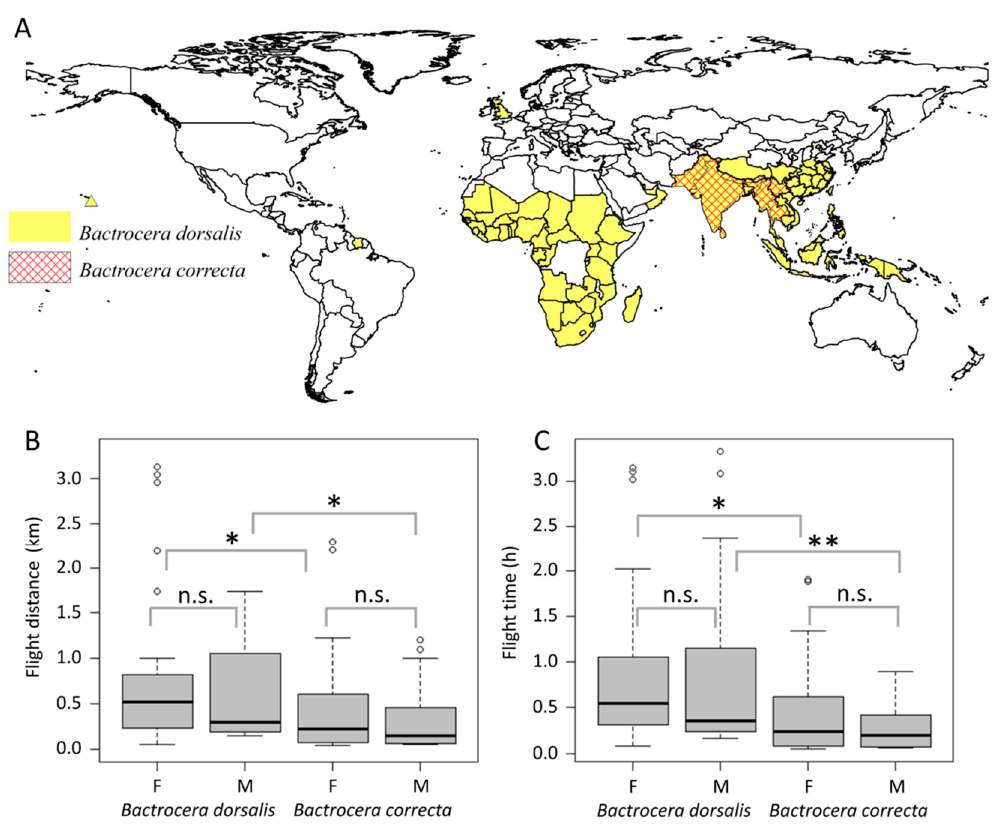
Figure 1. The geographical distribution and flight capacity of B. dorsalis and B. correcta. ( A ) The world map shows countries where the indicated species has been reported. The yellow region indicates the distribution of B. dorsalis , and the red quilting indicates the distribution of B. correcta. The map was created using ArcGIS 10.2 software (ESRI Inc., Redlands, CA, USA). Available online: http://www.esri.com/arcgis/about-arcgis; ( B ) The comparison of flight distances between B. dorsalis and B. correcta ; ( C ) The comparison of flight time between B. dorsalis and B. correcta . The circles show the outliers, the bold black line shows the median, the top edge of the bar shows the sample maximum and the lower edge of the bar shows the sample minimum. (F: female; M: male; n.s.: not significant; * p < 0.05, ** p < 0.01, according to the Student’s t test).